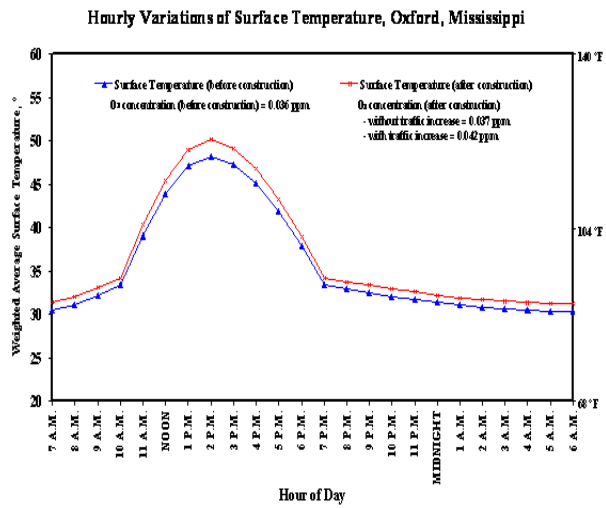
Figure 3: Hourly weighted average surface temperatures of the Highway 6-Jackson Avenue intersection area, Oxford, Mississippi, 11 July 2003.